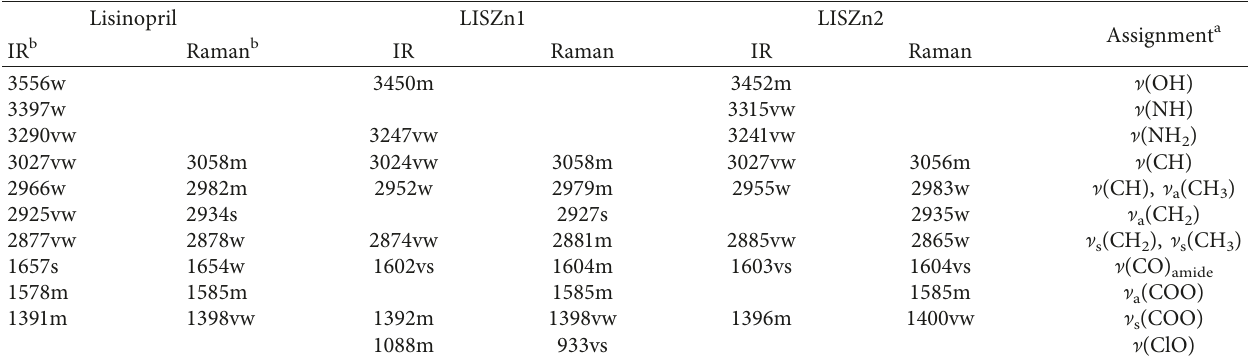
Table 1: Principal IR and Raman bands (cm − 1 ) for lisinopril, LISZn1, and LISZn2 compounds.